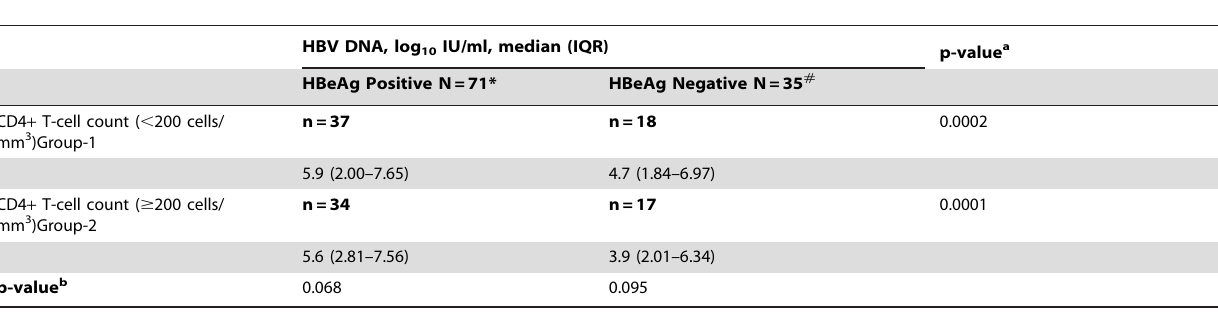
# Only HBV DNA positive subjects were considered from a total of 46 HBeAg negative subjects. *From a total 73 HBeAg positive subjects, CD4 + T-cell count data was available for 71 subjects based on which analysis was done. a p-value for inter-group comparison between HBeAg positive and negative subjects with respect to CD4 + T-cell count grouping. b p-value for intra-group comparison between HBeAg positive and negative patients with CD4 + T-cell count of , 200 cells/mm 3 and $ 200 cells/mm 3.